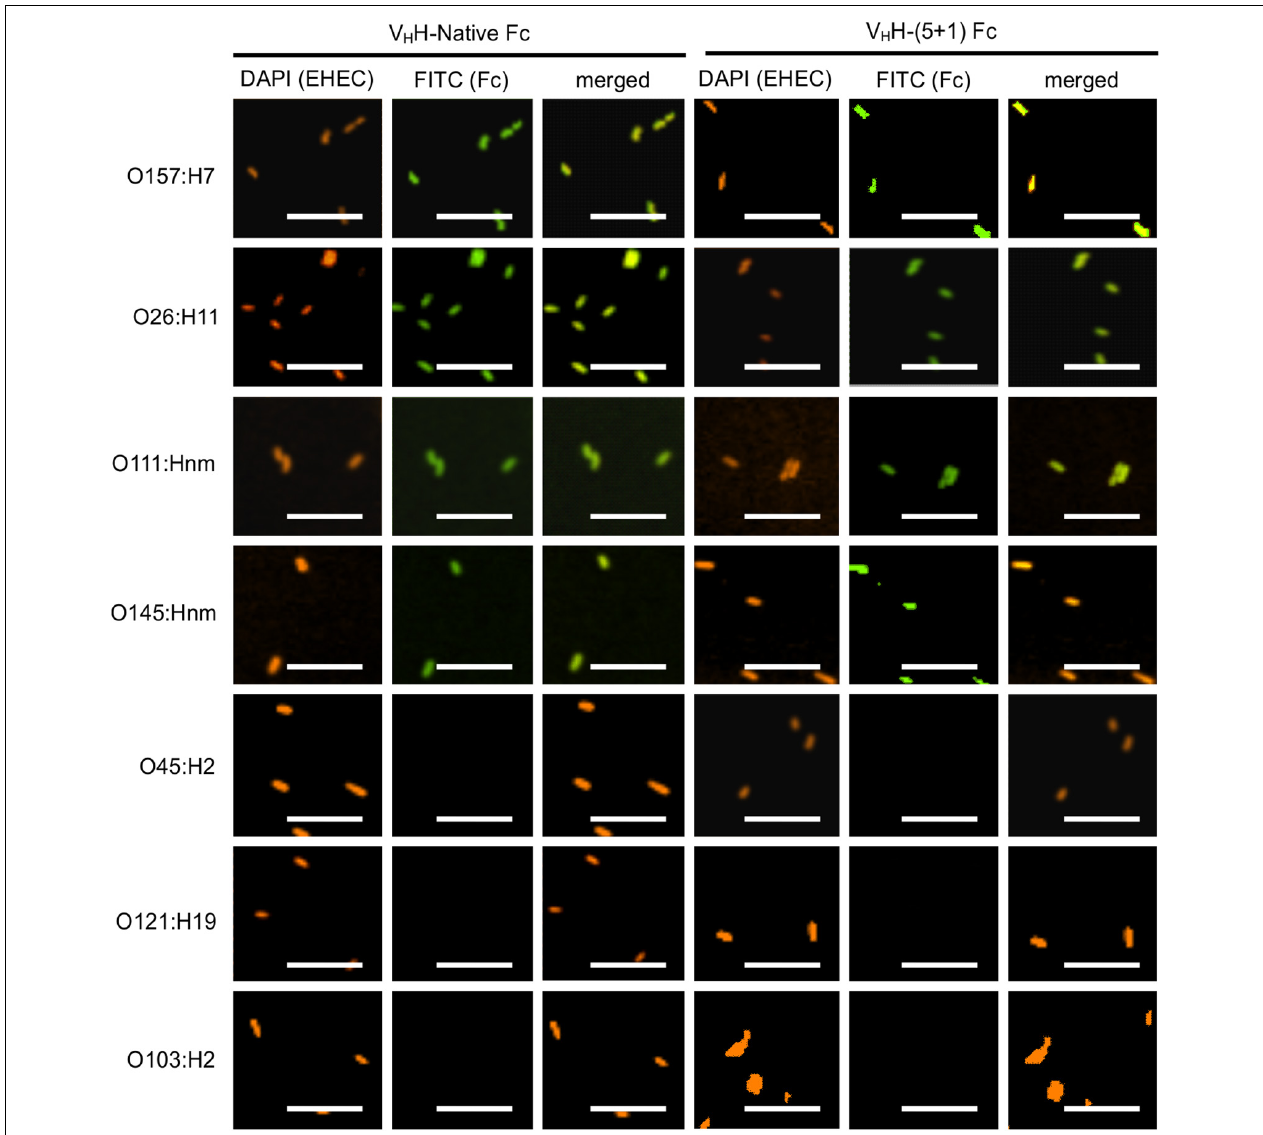
FIGURE 4 | V H H-(5 + 1) Fc retains the same binding pattern across EHEC strains as V H H-Native Fc. Shown are confocal images of the seven most prevalent EHEC strains incubated with either V H H-Native Fc or V H H-(5 + 1) Fc. DAPI was used to visualize EHEC cells (orange) and a FITC-conjugated antibody (green) was used to immunolabel the Fc specifically. Size bar = 10 µ